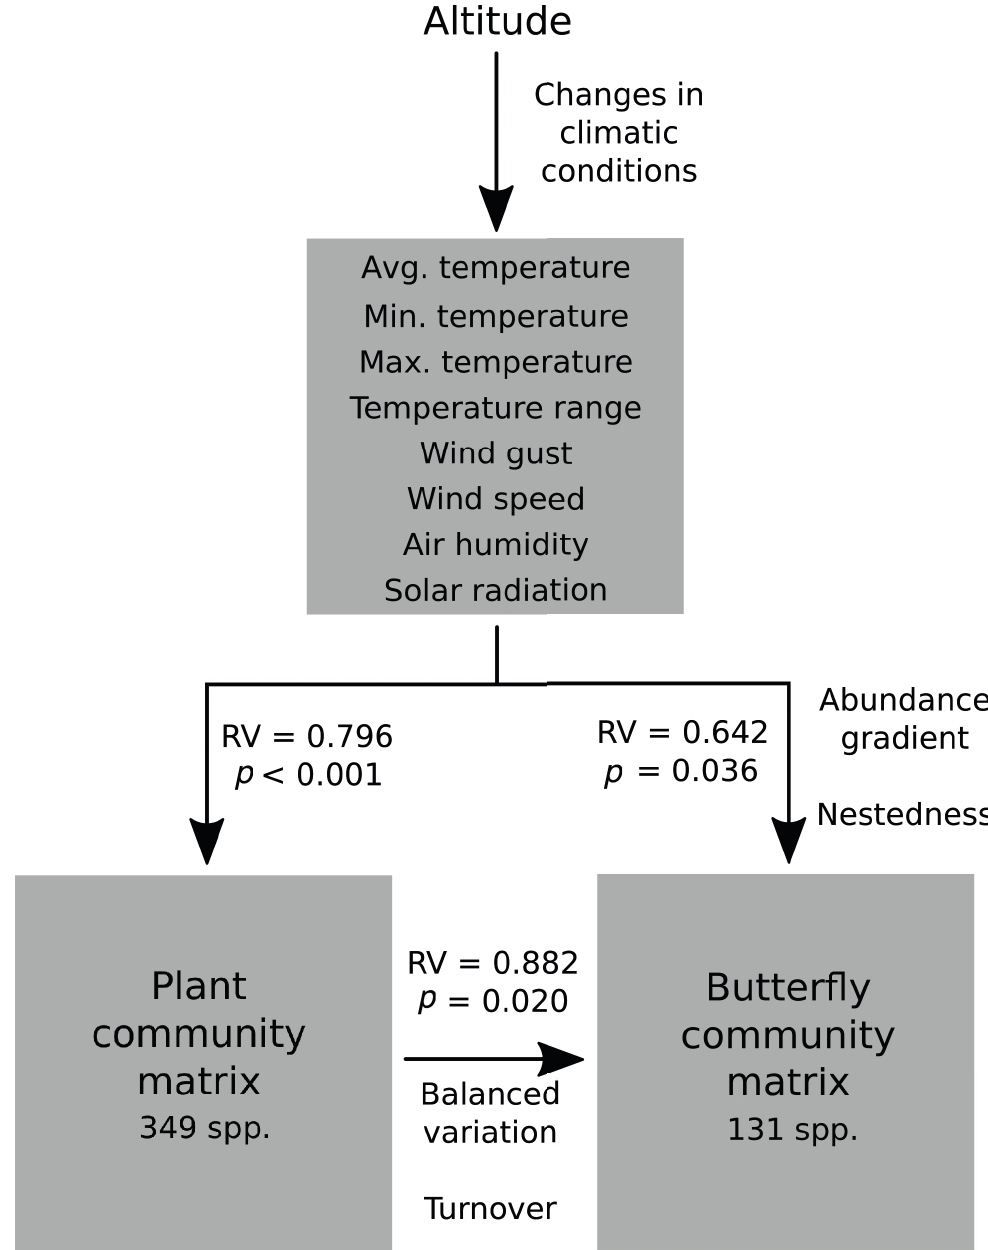
Figure 4. Results of co-inertia analysis (COIA) with the correlation coeffi cient ( RV -value) between the variable matrices of climate, and plant and butterfl y communities. The arrows represent the logical direction of the association between variable matrices. It shows climatic variables that are affected by altitude and have a strong infl uence on the plant and butterfl y communities. Also, the butterfl y communities are more strongly correlated to the plant communities (resource) than to the climate (condition). As a result, ‘Balanced variation’ (replacement of individuals of some species by individuals of other species) and ‘Turnover’ (species replacement) following the changes in plant community composition are more important components of community shifts than ‘Abundance gradient’ (the equal loss of individuals among all species) and ‘Nestedness’ (the nestedness-resultant component in each altitude comparison). ‘Avg. temperature’ = average temperature, ‘Min. temperature’ = minimum temperature, ‘Max. temperature’ = maximum